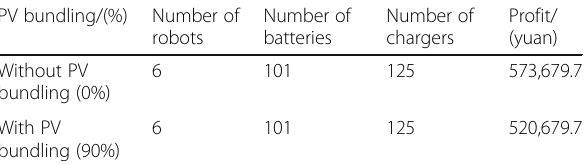
Table 3 The optimal configuration solutions under scenarios with and without PV bundling PV bundling/(%) Number of Number of robots batteries